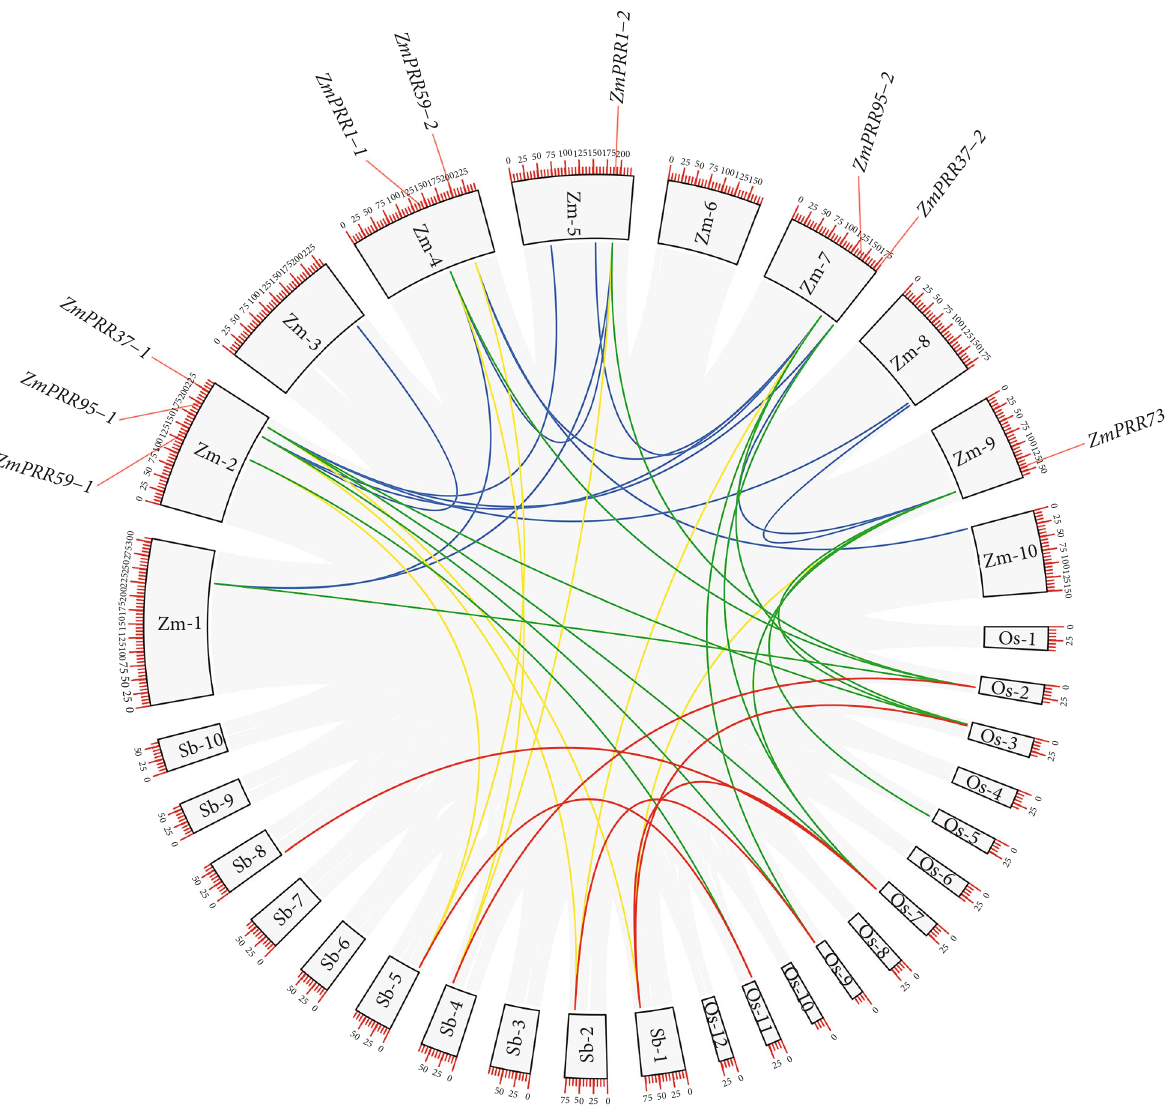
Figure 3: Synteny relationship of PRR regions across Zea mays , Oryza sativa , and Sorghum bicolor . The Zea mays , Oryza sativa , and Sorghum bicolor chromosomes are labeled as Zm , Os , and Sb , respectively. The ZmPRRs involved in duplications are mapped to their respective locations of the maize genome in the circular diagram. Numbers along each chromosome box indicate sequence lengths in megabases. Synteny blocks between maize and related grasses were detected and connected by lines in di ff erent colors. Blue lines represent the syntenic relationships between ZmPRRs and ZmPRRs regions. Green lines represent the syntenic relationships between OsPRRs and ZmPRRs . Yellow lines represent the syntenic relationships between SbPRRs and ZmPRRs . Red lines represent the syntenic relationships between SbPRRs and OsPRRs . Gray lines represent all syntenic regions in the whole